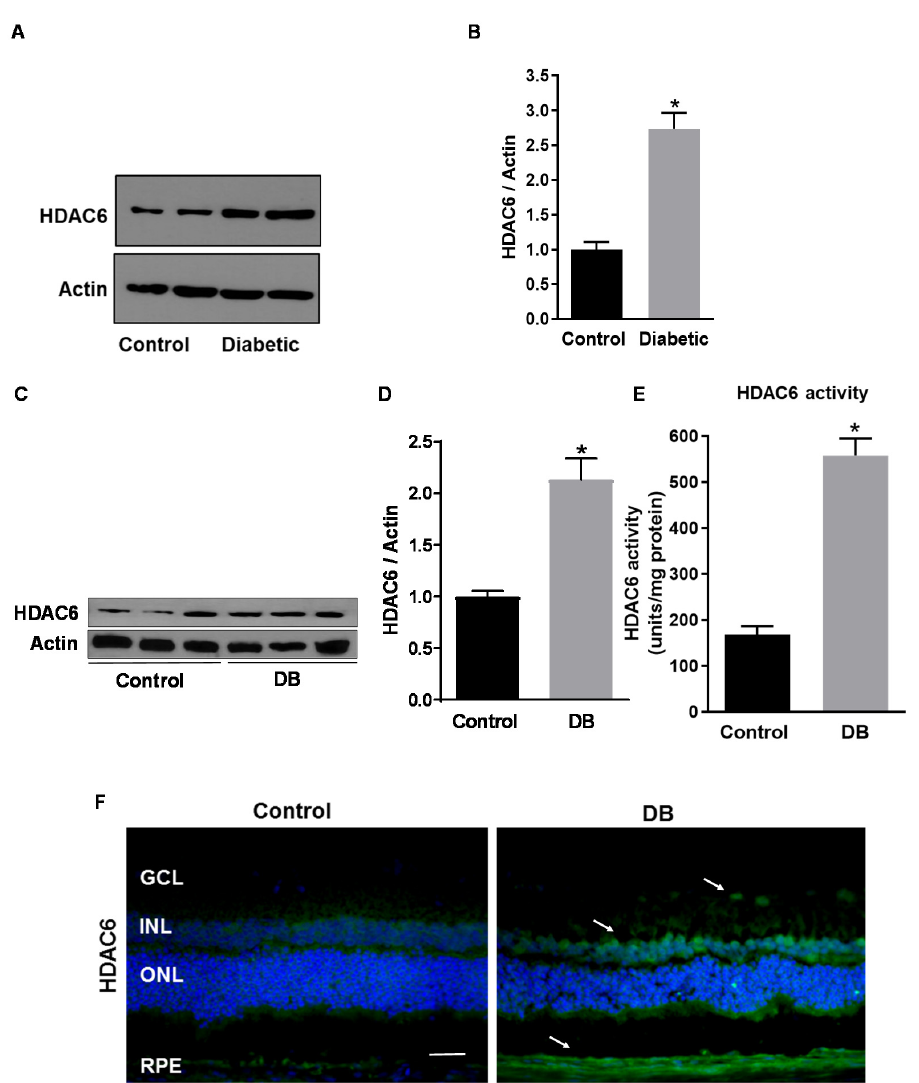
Figure 1. Histone deacetylase 6 (HDAC6) expression in the diabetic retina. ( A ) Western blotting analysis measuring HDAC6 protein levels in human postmortem retinas from diabetic and non ‐ diabetic donors (control). ( B ) Bar histograms representing relative optical densities from the immunoblotting shown in (A) and normalized versus the loading control actin. Values are expressed as mean ± SEM for n = 8. * p < 0.01 vs. control. ( C ) Western analysis of HDAC6 protein expression in retinas of streptozotocin ‐ induced diabetic rats (STZ ‐ rats) (DB) at 8 weeks of hyperglycemia and age ‐ matched normoglycemic control rats (control). ( D ) Bar histograms representing densitometric quantification of HDAC6 protein levels normalized to actin. ( E ) HDAC6 activity measured, by a fluorimetric assay, in retinas of STZ ‐ rats and control normoglycemic rats. ( F ) Representative microimages of immunohistochemical analysis of HDAC6 (green) in retinas of STZ ‐ rats at 8 weeks of hyperglycemia and of age ‐ matched normoglycemic control rats. Nuclei were stained with 4 ′ ,6 ‐ diamidino ‐ 2 ‐ phenylindole (DAPI). White arrows indicate areas of increased immunoreactivity. Scale bar, 50 μ m. Values are expressed as mean ± SEM for n = 6. * p < 0.01 vs. control.